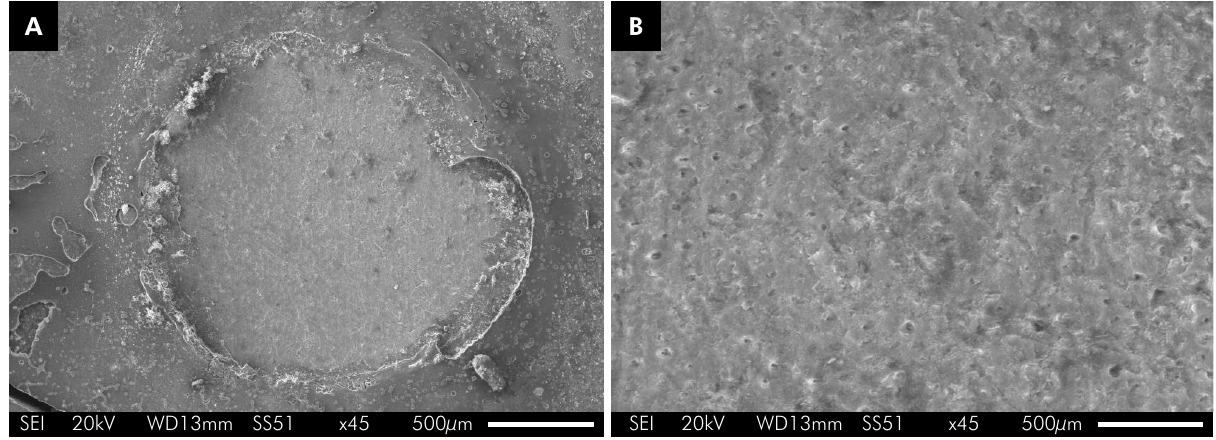
Figure 2. SEM micrographs showing the adhesive failure at lower (45× – A) and higher (500× – B)